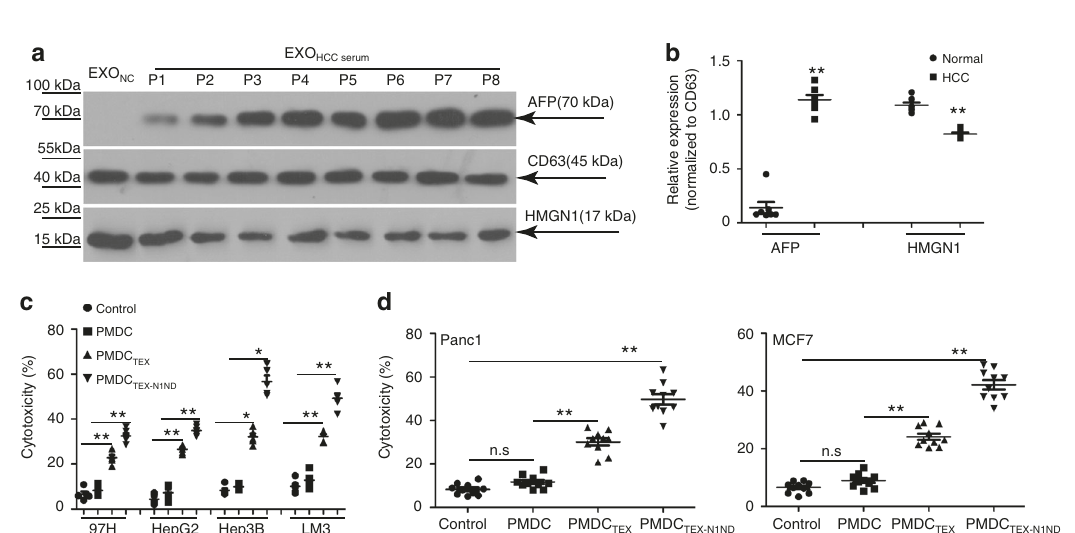
Fig. 7 TEX-N1ND augmented human DC immunity. a Western blot analysis for detecting the levels of HMGN1 and AFP expression in serum exosomes derived from normal healthy volunteers and HCC patients. Total protein (20 μ g) was loaded and CD63 was used as an exosomal marker protein. This experiment was repeated once (two in total). b Quantitative analysis of levels of HMGN1 (two-tailed t test) and AFP (two-tailed Mann-Whitney U test) in serum exosomes derived from normal healthy volunteers ( n = 7) and HCC patients ( n = 8). c Cytolysis rate against different human HCC cells with PMDC TEX-N1ND and PMDC TEX . TEXs were derived from HCC patients ’ serum. PMDC means peripheral mononuclear-derived dendritic cell. A LDH-releasing cytotoxic assay was performed to measure the cytolysis ef fi ciency of effector lymphocytes activated by PMDC TEX-N1ND or PMDC TEX , respectively ( n = 5; one-way ANOVA post hoc Student – Newman – Keuls test except for Hep3B in which one-way ANOVA on ranks was used). Control refers to human PBMC- derived lymphocytes. d Cytolysis rate against human pancreatic and breast cancer cells with PMDC TEX-N1ND and PMDC TEX . TEXs were derived from pancreatic or breast cancer patients ’ serum, respectively ( n = 10; one-way ANOVA on ranks). These experiments were repeated once (two in total). Data are presented as means± s.e.m. (* p < 0.05; ** p < 0.001; n.s not signi fi cant). Source data are provided as a Source Data fi